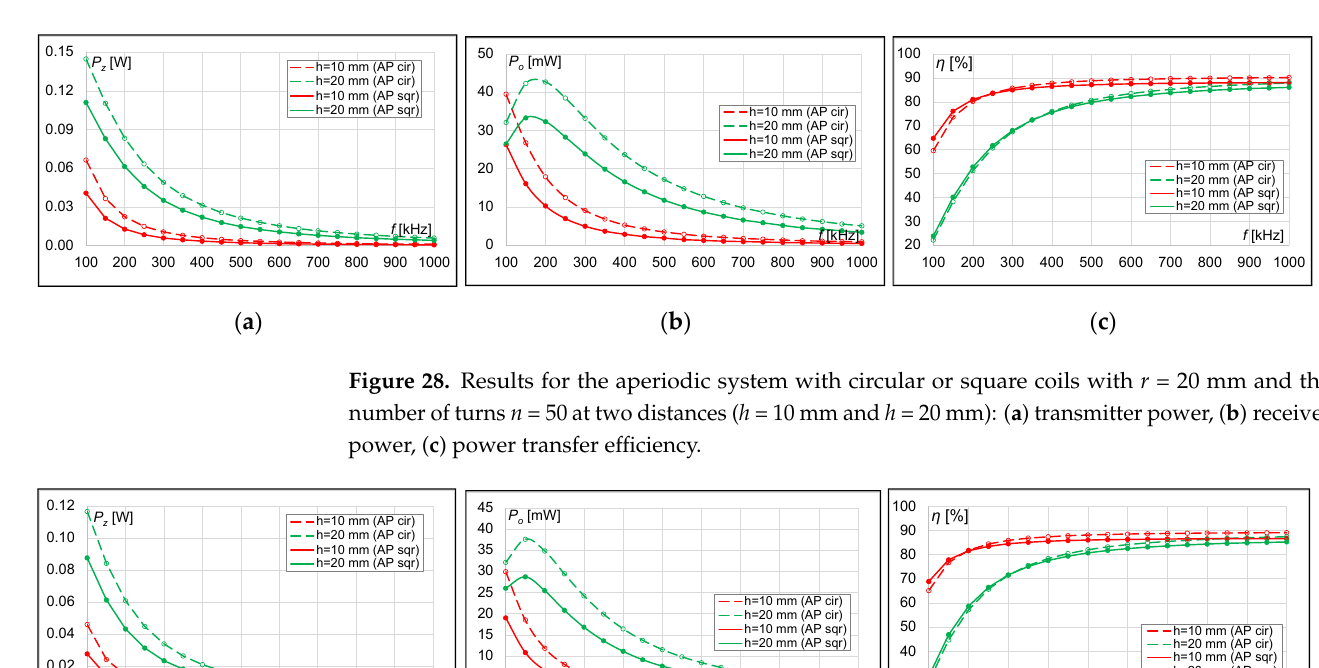
Figure 27. Results for the aperiodic system with circular or square coils with r = 20 mm and the number of turns n = 40 at two distances ( h = 10 mm and h = 20 mm): ( a ) transmitter power, ( b ) receiver power, ( c ) power transfer efficiency.